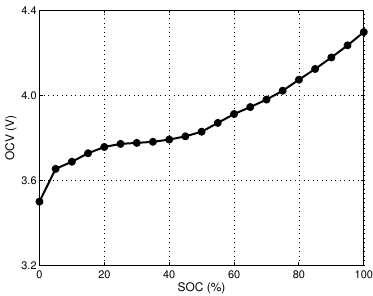
Figure 2. Open circuit voltage (OCV)-state of charge (SOC) curve at room